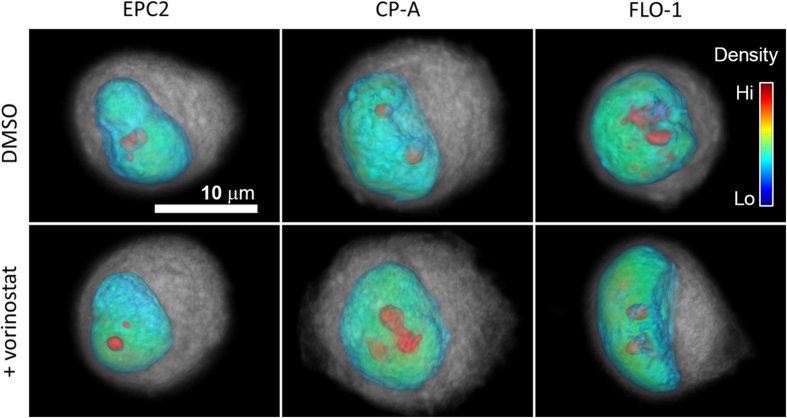
Treatment with vorinostat preferentially decreases the nuclear size and intra-nuclear clumpiness in FLO-1 cancer cells relative to metaplastic and normal squamous esophageal epithelial cells.Representative volume renderings of cells imaged by single-cell optical CT illustrate the surface morphology and nuclear interior of DMSO-treated (top row), and vorinostat-treated (bottom row) EPC2 (left column), CP-A (middle column), and FLO-1 (right column) cells. The cytoplasm is gray, nuclear envelope is blue, and increasing nuclear density is color coded from green to red as indicated by the color scale bar.